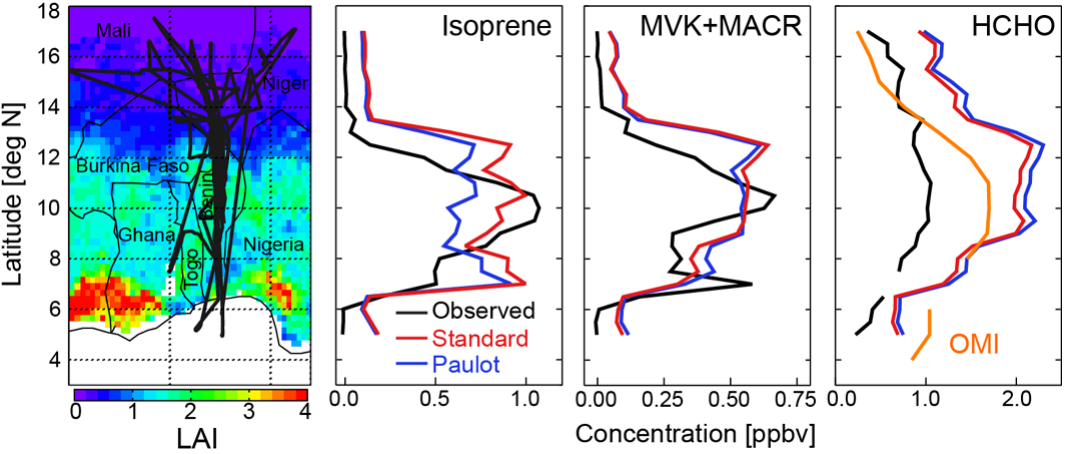
Fig. 5. Mean latitudinal gradients of boundary layer ( < 1km) isoprene, MVK+MACR, and HCHO concentrations during the AMMA aircraft campaign in July–August 2006. The left panel shows the AMMA flight tracks superimposed on a map of MODIS leaf area index (LAI) (Yang et al., 2006) for the AMMA period. Observations averaged over 0.5 ◦ latitudinal bins are shown in black. Model results sampled along the flight tracks and at the flight times are shown in red (standard GEOS-Chem isoprene oxidation scheme) and in blue (Paulot scheme). Mean OMI HCHO averaged over 1 ◦ latitude bins for July–August 2005–2009 is shown in orange (see